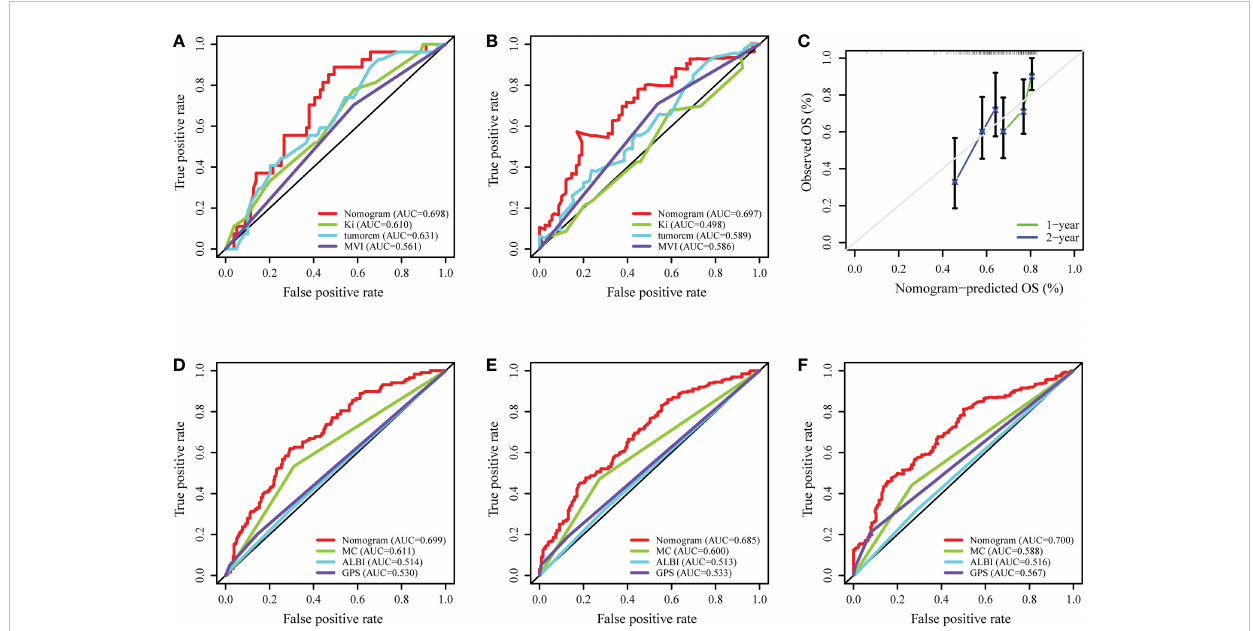
FIGURE 6 External validation and comparison of the nomogram model with the conventional prognostic evaluation systems. (A, B) ROC curves of the nomogram model predicting the 1- and 2-year RFS in validation cohort. (C) The calibration plot of the nomogram for RFS in validation cohort. (D – F) ROC curves of the nomogram model and the conventional prognostic evaluation systems predicting the 1-, 3- and 5-year RFS of HCC patients. MC, Milan criteria; ALBI, Albumin-Bilirubin grade; GPS, Glasgow Prognostic Score.